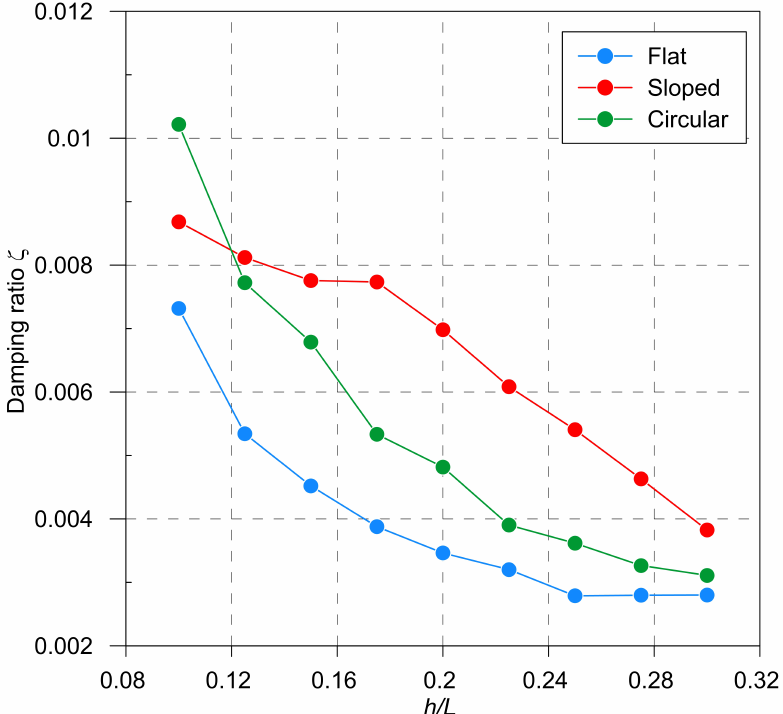
Figure 11. Damping coefficients vs. water depth ratio for different bottom